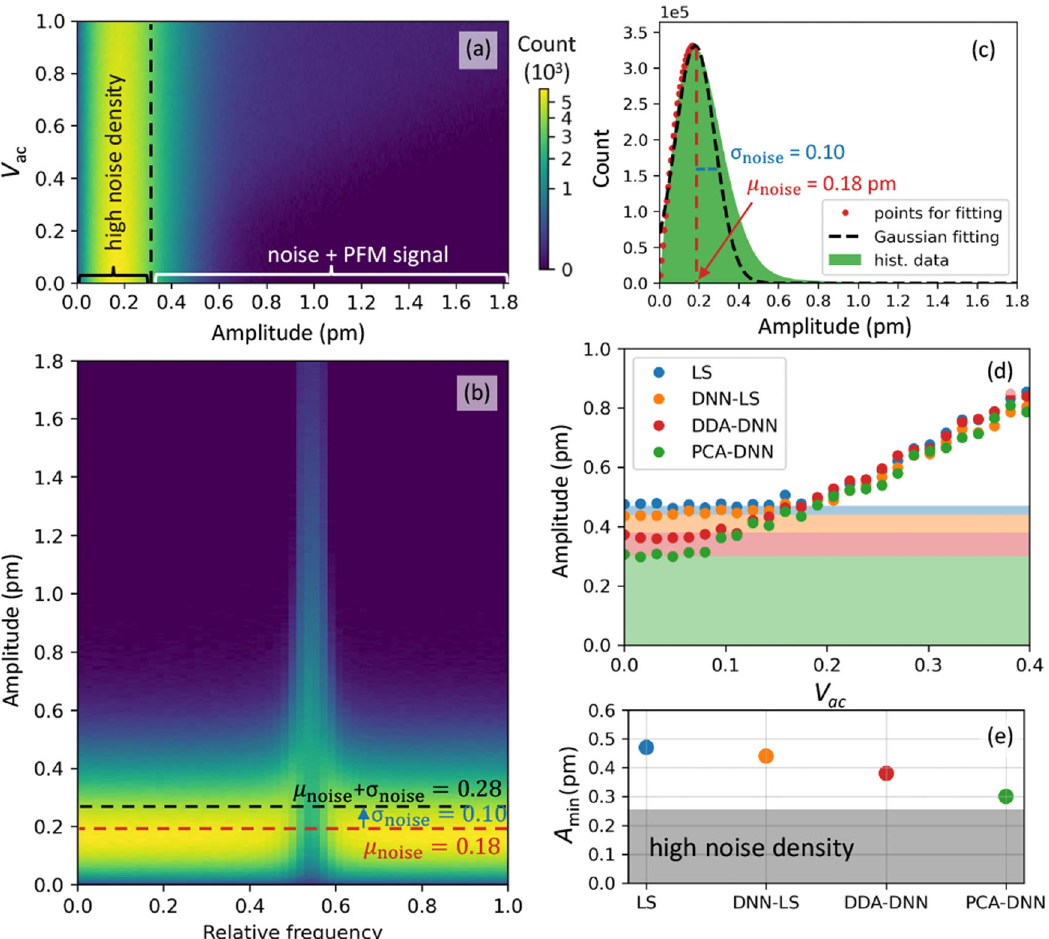
Fig. 4 As-acquired signal of the PPLN dataset from the V ac amplitude sweep measurement. a Amplitude spectral density as a function of V ac , ( b ) amplitude spectral density as a function of a relative frequency, and ( c ) amplitude histogram with a Gaussian fi t to obtain the steady noise fl oor. The Gaussian fi t was performed on the half lower part, indicated by the red dotted line, to avoid fi tting on the PFM signal. d The averaged fi tted amplitude as a function of V ac . The highlighted level is the baseline of which the amplitude value is constant. The minimum detectable displacement A min , which is the baseline extracted from ( d ), is plotted in ( e ). The shadow highlight in ( e ) indicates the high noise density